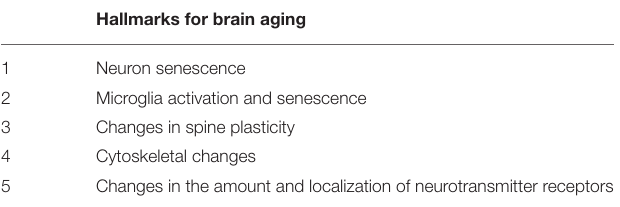
TABLE 2 | Some hallmarks of brain